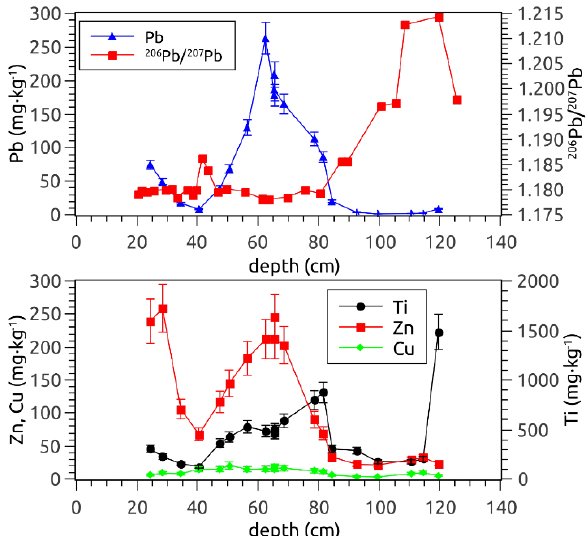
Figure 3. Pb, 206 Pb/ 207 Pb, Ti, Zn and Cu proxies versus peat